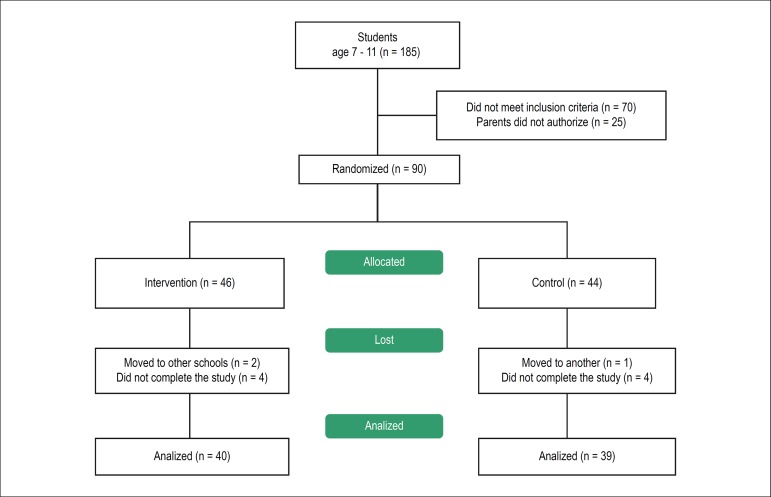
CONSORT ﬂow chart depicting recruitment and randomization of the children
into the study groups.